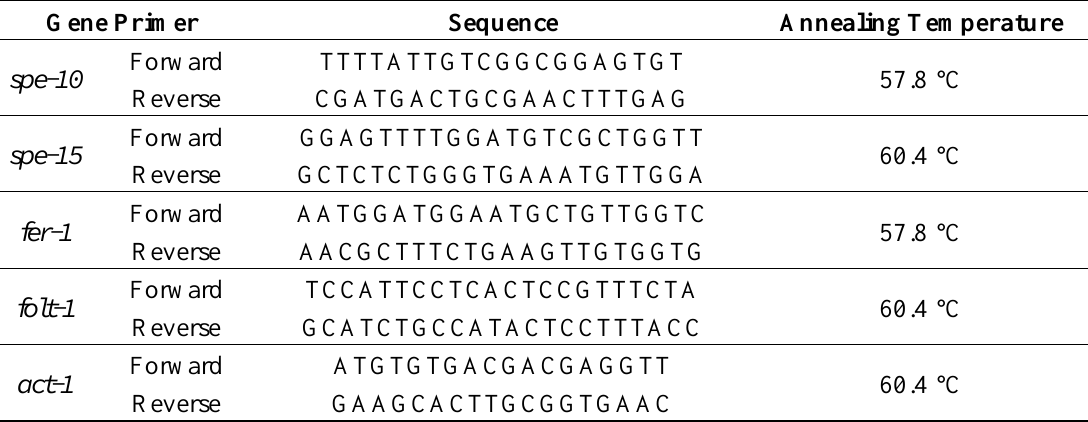
Table 1. Gene primers tested in the